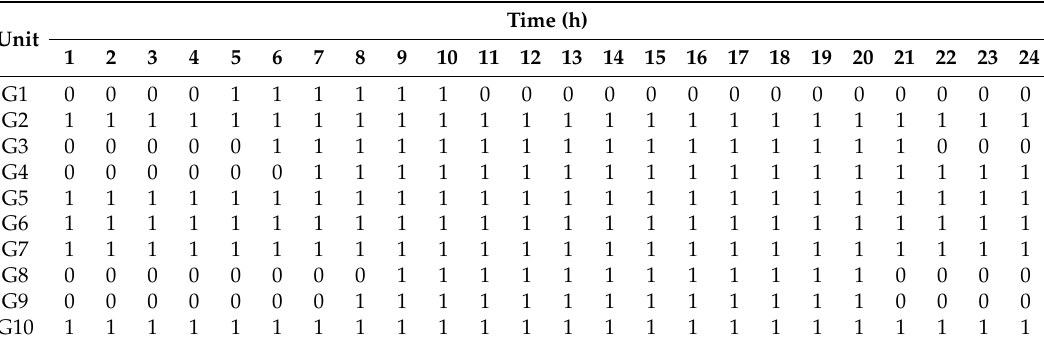
Table 5. Unit commitment schedule obtained using Algorithm